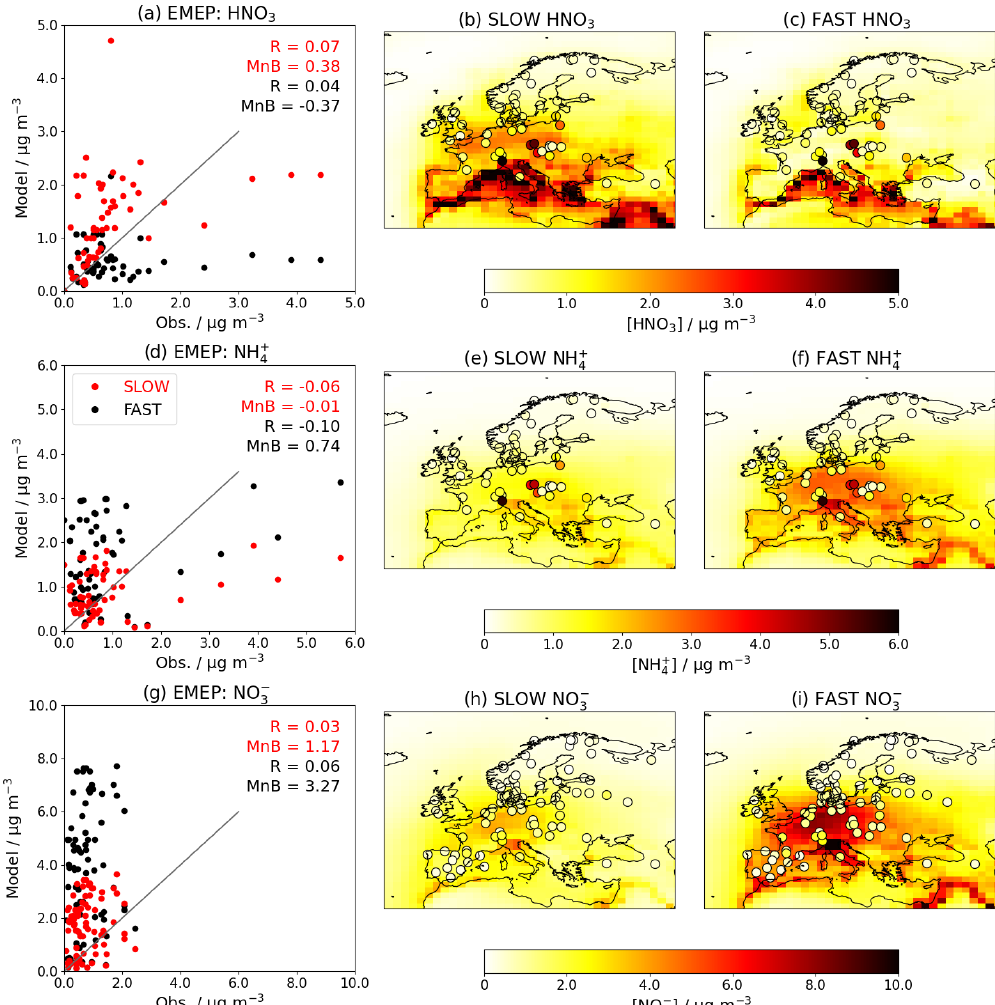
Figure 6. Annual-mean HNO 3 , NH 4 , and total-NO 3 near-surface concentrations for the FAST and SLOW simulations over Europe compared to EMEP observations averaged over 1994–2013 where available. In panels (b, c, e, f, h, i) , coloured contours show simulated concentrations while overlaid filled circles represent EMEP observations. In panels (a, d, g) , “R” is the Pearson’s correlation coefficient, and “MnB” is the mean bias between simulated and observed